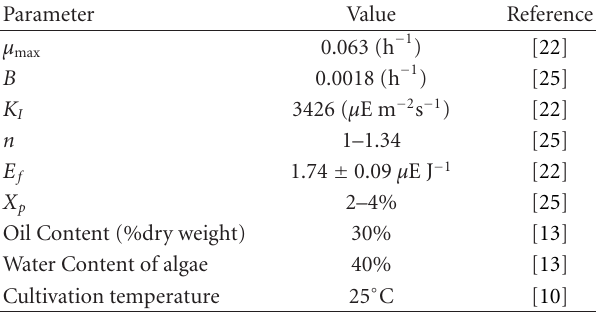
Table 3: P. tricornutum growth